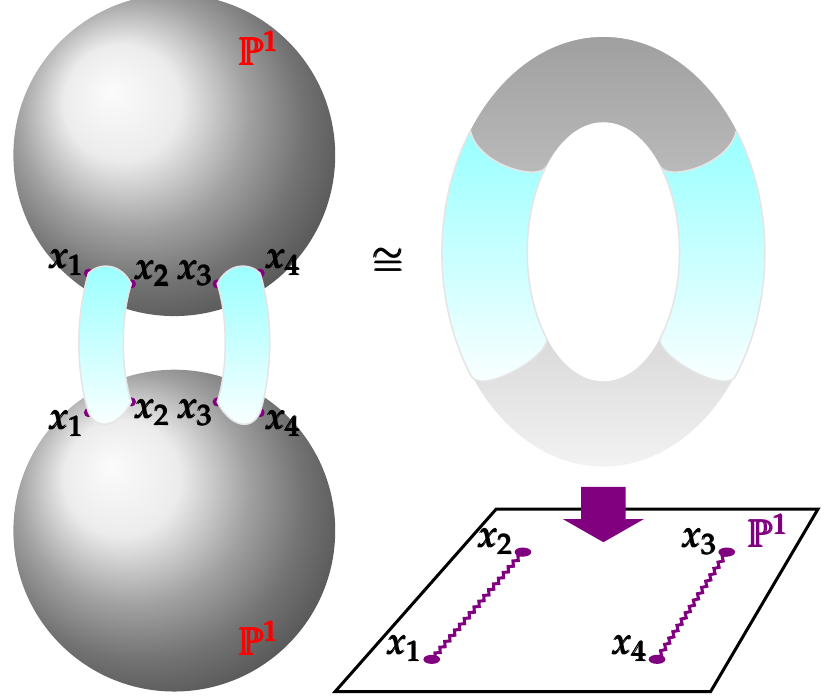
Figure 15. Two double cut P 1 planes glued along the cuts are topologically equivalent to a torus.